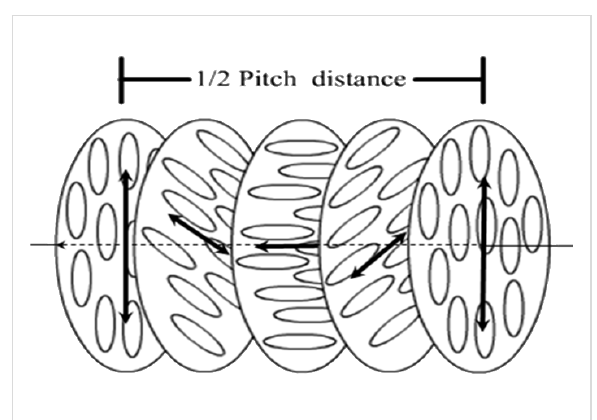
Figure 1: Schematic structure of a right-handed chiral nematic (cholesteric) phase. Black arrows represent the director, which rotates perpendicularly to an axis in a helical manner. Molecules (represented as ellipsoids) can take any orientation, but are preferentially aligned to the